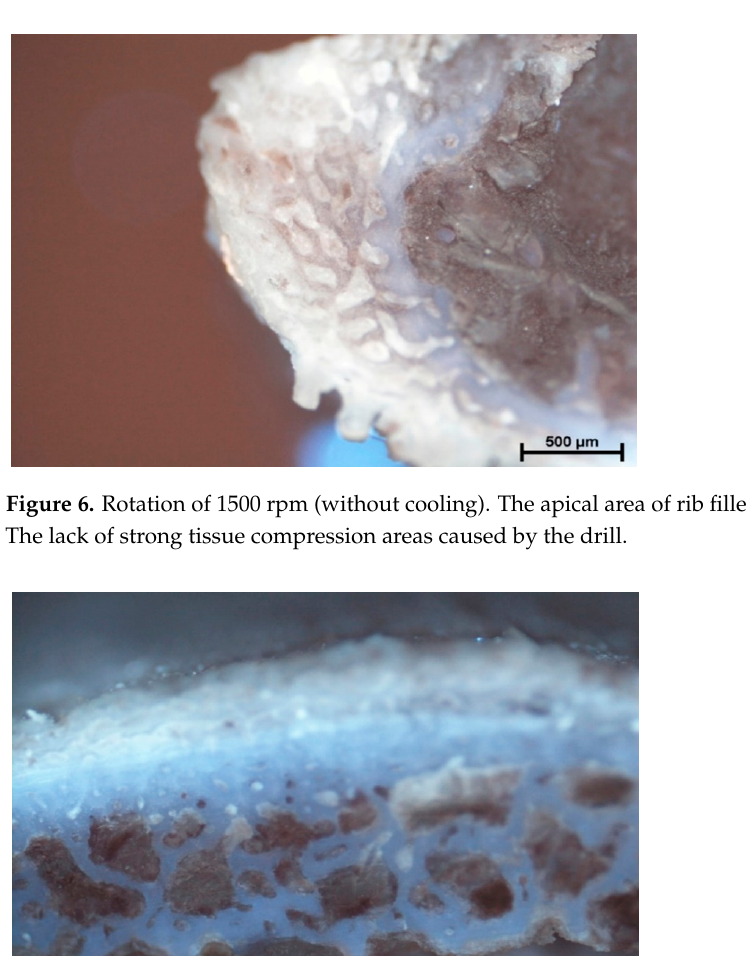
Figure 5. Rotation of 1200 rpm (3 °C). Total destruction of bone tissue and bone marrow. Visible empty bone marrow cavity (arrow) clearly distinguished from other parts of unchanged rib tissue.